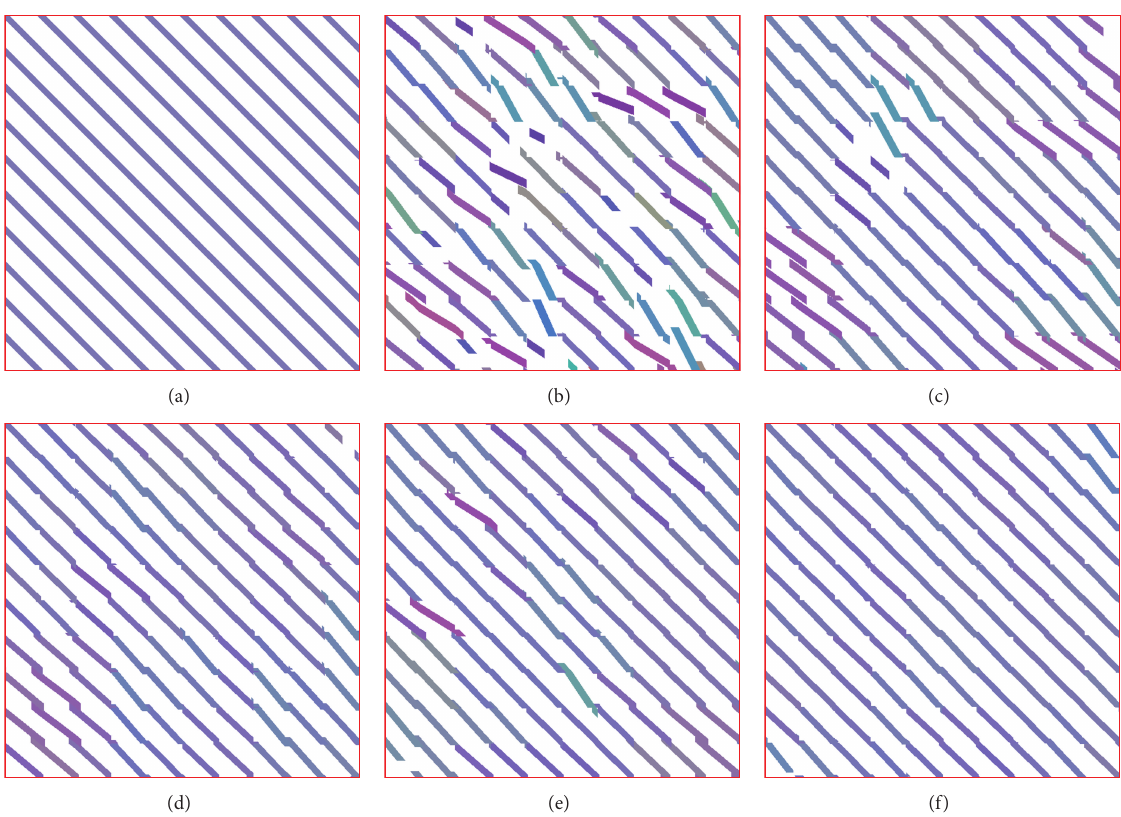
Figure8:Filteringofsyntheticdata 𝐴 𝐼𝐼 corruptedwithGaussiannoisehavingzeromeanand 𝜎 =0.01:(a)theoriginalimage,(b)thedisturbed image, and the reconstructed images using (c) SM2D, (d) SF2D, (e) SM3D, and (f) SF3D.